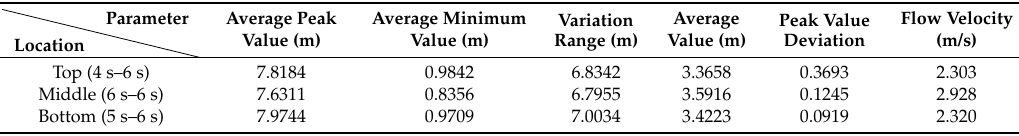
Table 12. Flushing results when the slot nozzle is set at different